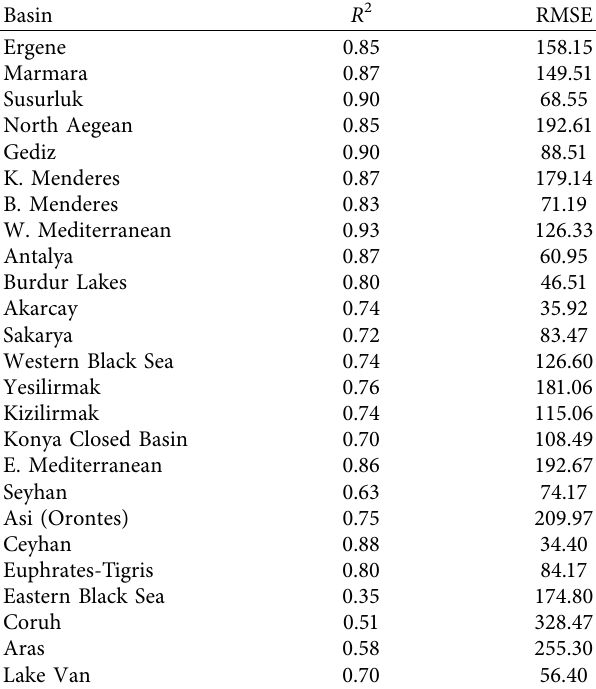
Table 7: R 2 and RMSE results for CFSR data.